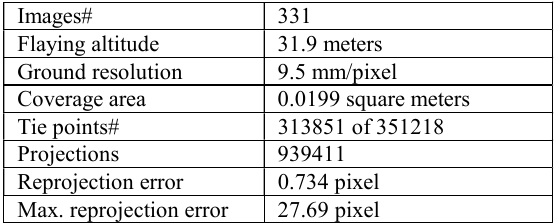
Table 2. Project data and sparse point cloud creation results